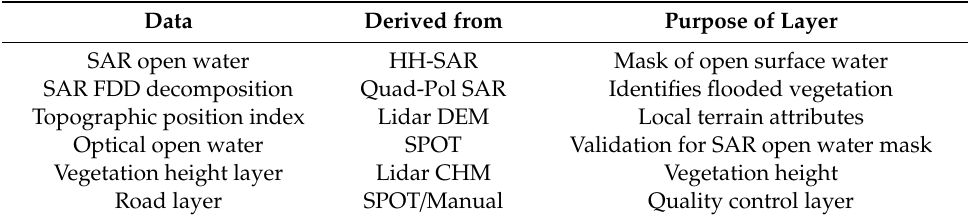
Table 1. Data layers used in the classification and associated